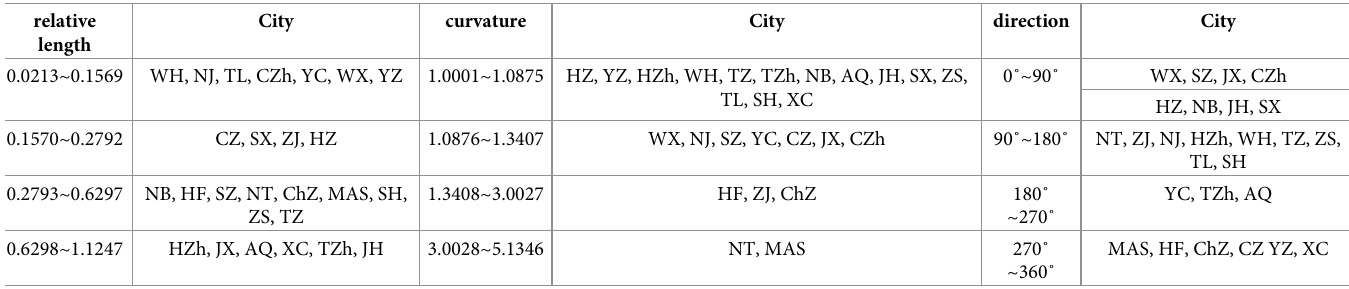
shortest relative length (0.021). (2) In terms of curvature, the change is not obvious. There are 14 cities in the lower level, accounting for 53.8%, which indicates that the fluctuation of each city and its adjacent cities in the direction of spatial dependence is relatively stable. Maanshan had the largest curvature (5.135), followed by Nantong (3.011), and Hefei (2.248), reflecting that these cities and their neighboring cities are significantly affected by spatiotemporal Table 4. LISA time path evolution of HDCT. relative City curvature City direction length